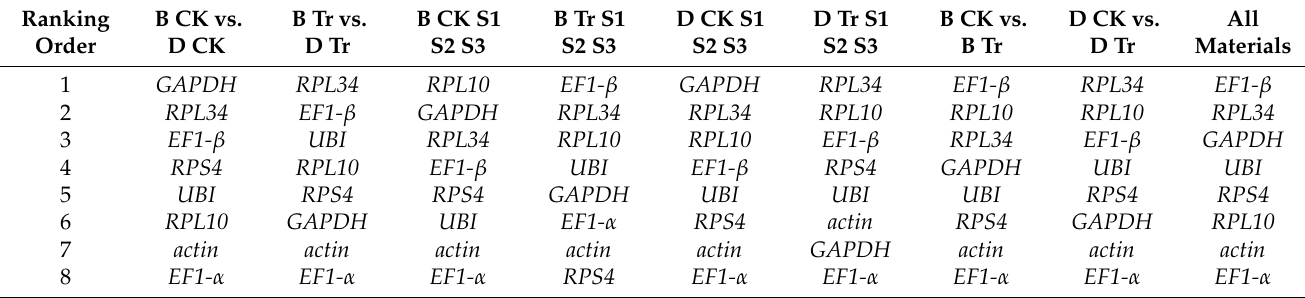
Table 6. Rank of candidate reference genes were calculated by RefFinder in each